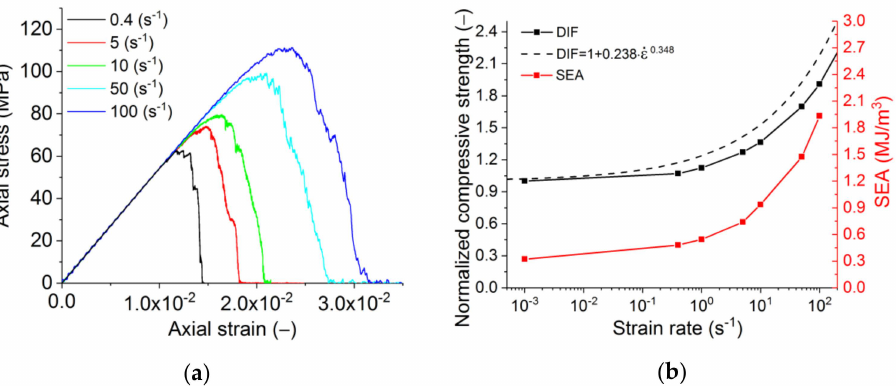
Figure 10. Results for dynamic compressive loading: ( a ) stress–strain diagrams, ( b ) effect of the strain rate on normalized strength and specific energy absorption (SEA). The dashed line is the averaging analytical approximation of experimental data for various brittle and quasi-brittle materials